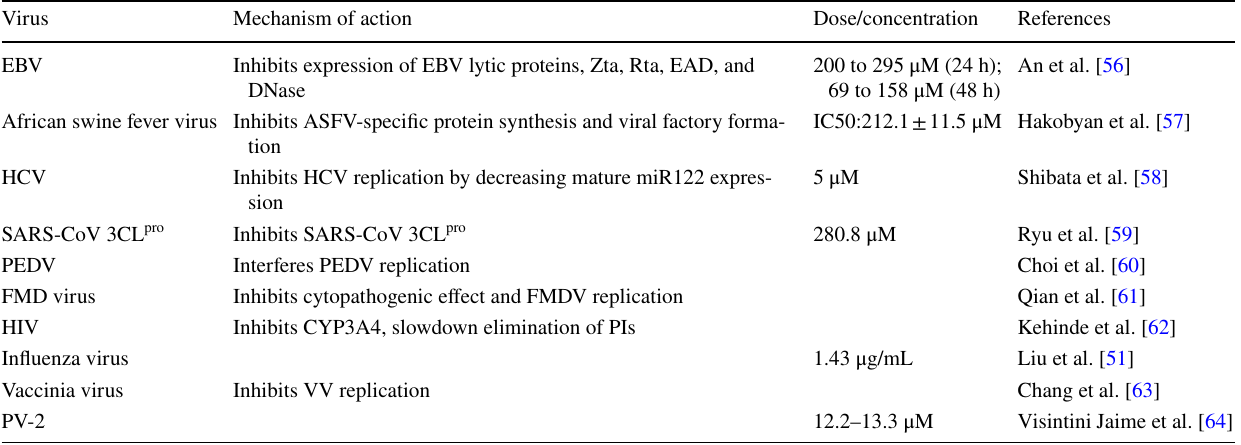
Table 4 Anti-virus activity of apigenin Virus Mechanism of action